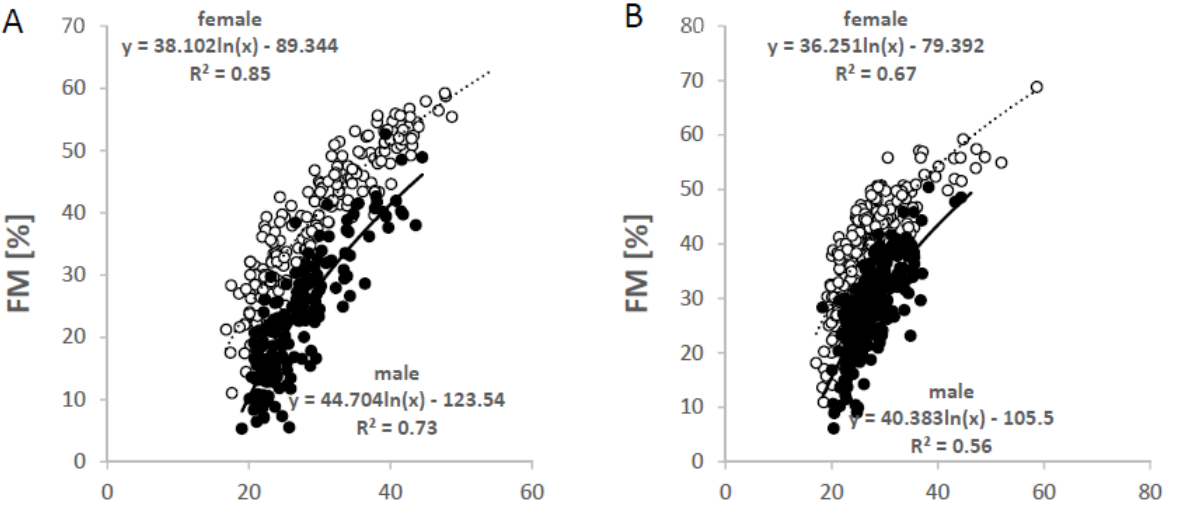
Figure 2. Non-linear plot of the association between BMI and percentage fat mass (%FM, as estimated by ADP) in females (open symbols) and males (closed symbols) at age ≤ 40 yrs ( A ) and >40 yrs ( B ) (‘Kiel study population’, n = 908 subjects; 54% females and 46% males; age range of 18 to 86 yrs). As for the association between %FM and BMI, BMI data were transformed to the natural logarithm scale to minimize